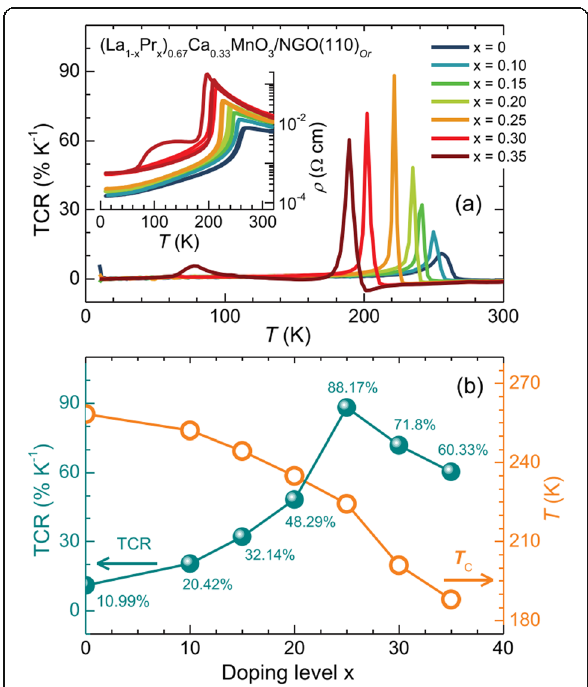
Fig. 37 a Temperature dependence of TCR for the 30 nm (La 1-x Pr x ) 0.67 Ca 0.33 MnO 3 (LPCMO)/ NdGaO 3 (NGO) films at various doping levels ( x = 0 – 0.35) at zero field. The inset shows the corresponding ρ - T curves. b T C and TCR (peak value) as a function of the Pr doping level x, extracted from the ρ - T curves measured during cooling. Reproduced with permission of